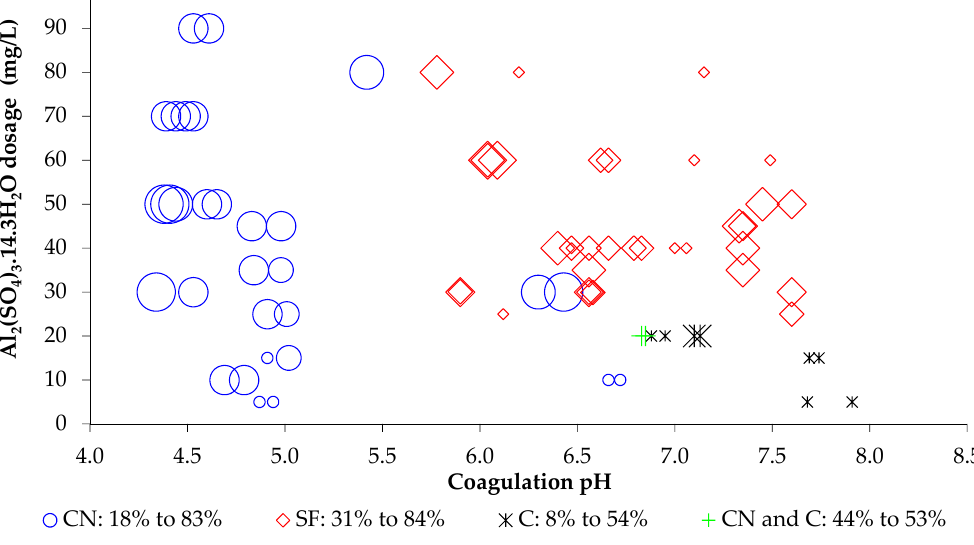
Figure 4. Coagulation diagrams with color removal points in relation to coagulation pH and dosage of aluminium sulfate in water samples Type I, II and III—Conventional Jar Test.